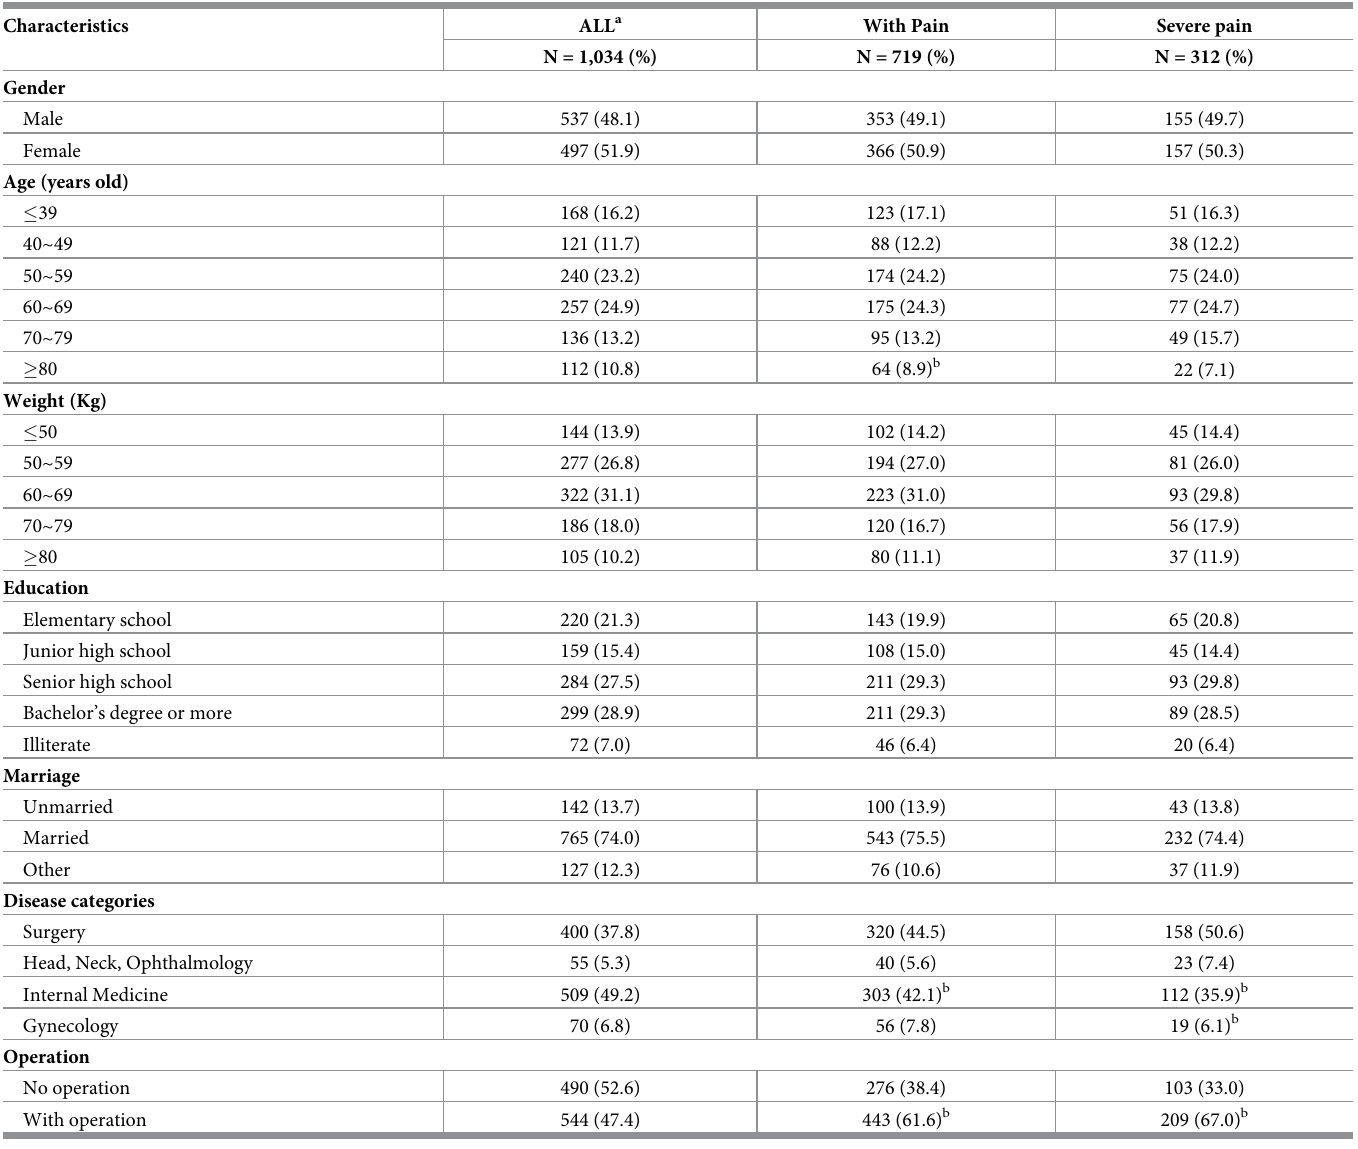
Table 1. Demographic data and risk factors for pain and severe